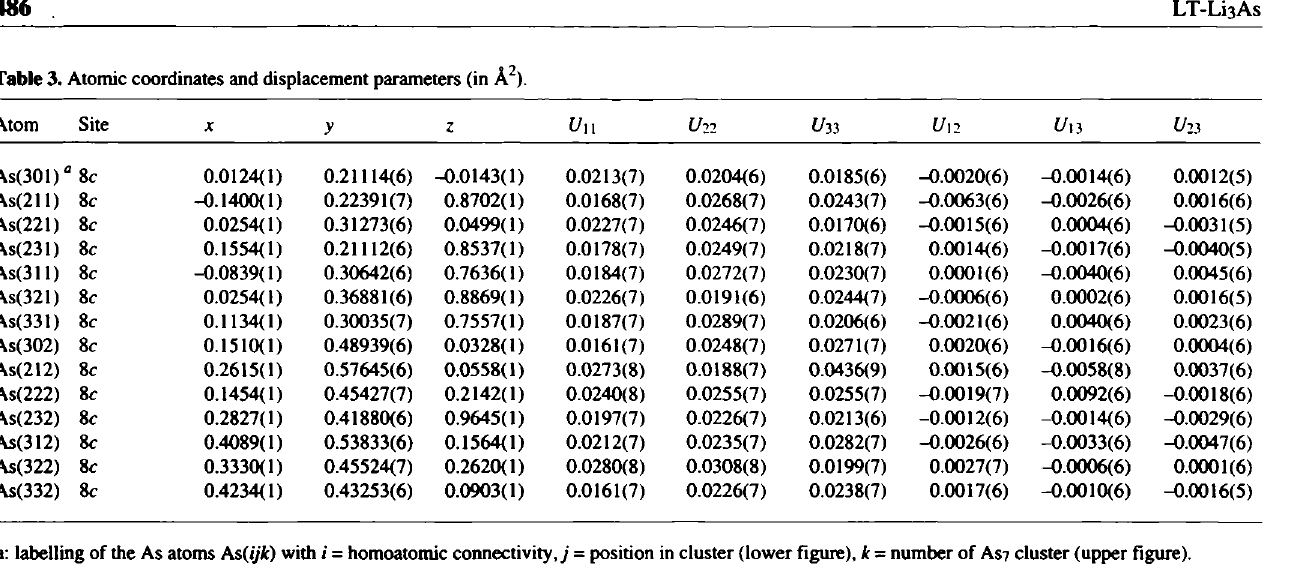
Table 3. Atomic coordinates and displacement parameters (in Â 2